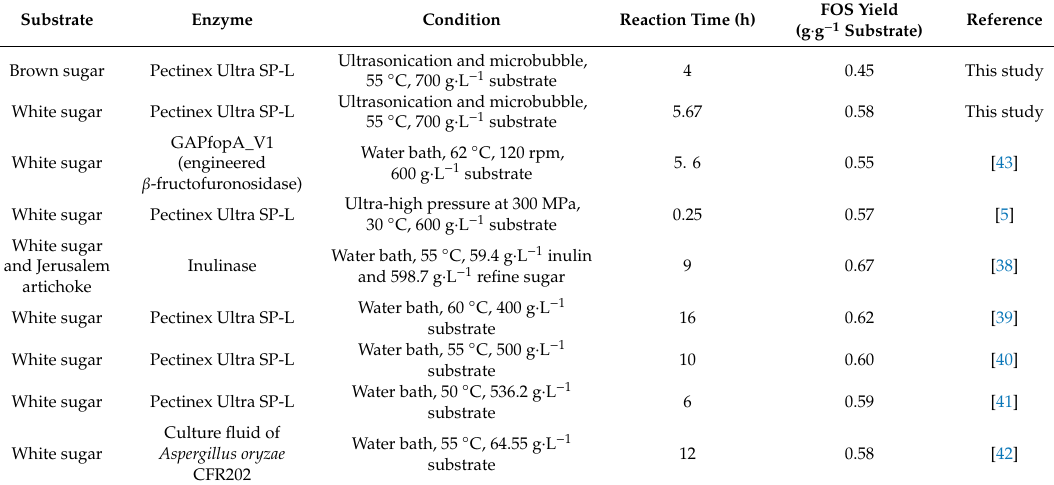
Figure 2. Fructooligosaccharide production from brown sugar in 100 mL, 1.5 L and 5 L batches. ( a ) Total FOS yield, ( b ) 1-Kestose yield, ( c ) Nystose yield, and ( d ) 1 F - β -fructofuranosylnystose yield. Table 5. Comparison of FOS production from this study and other